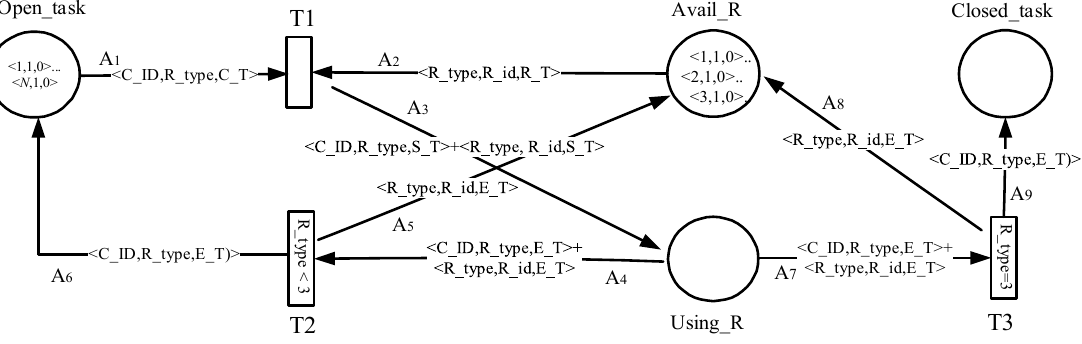
Figure 10. A Predicate/Transition net model for simulation.